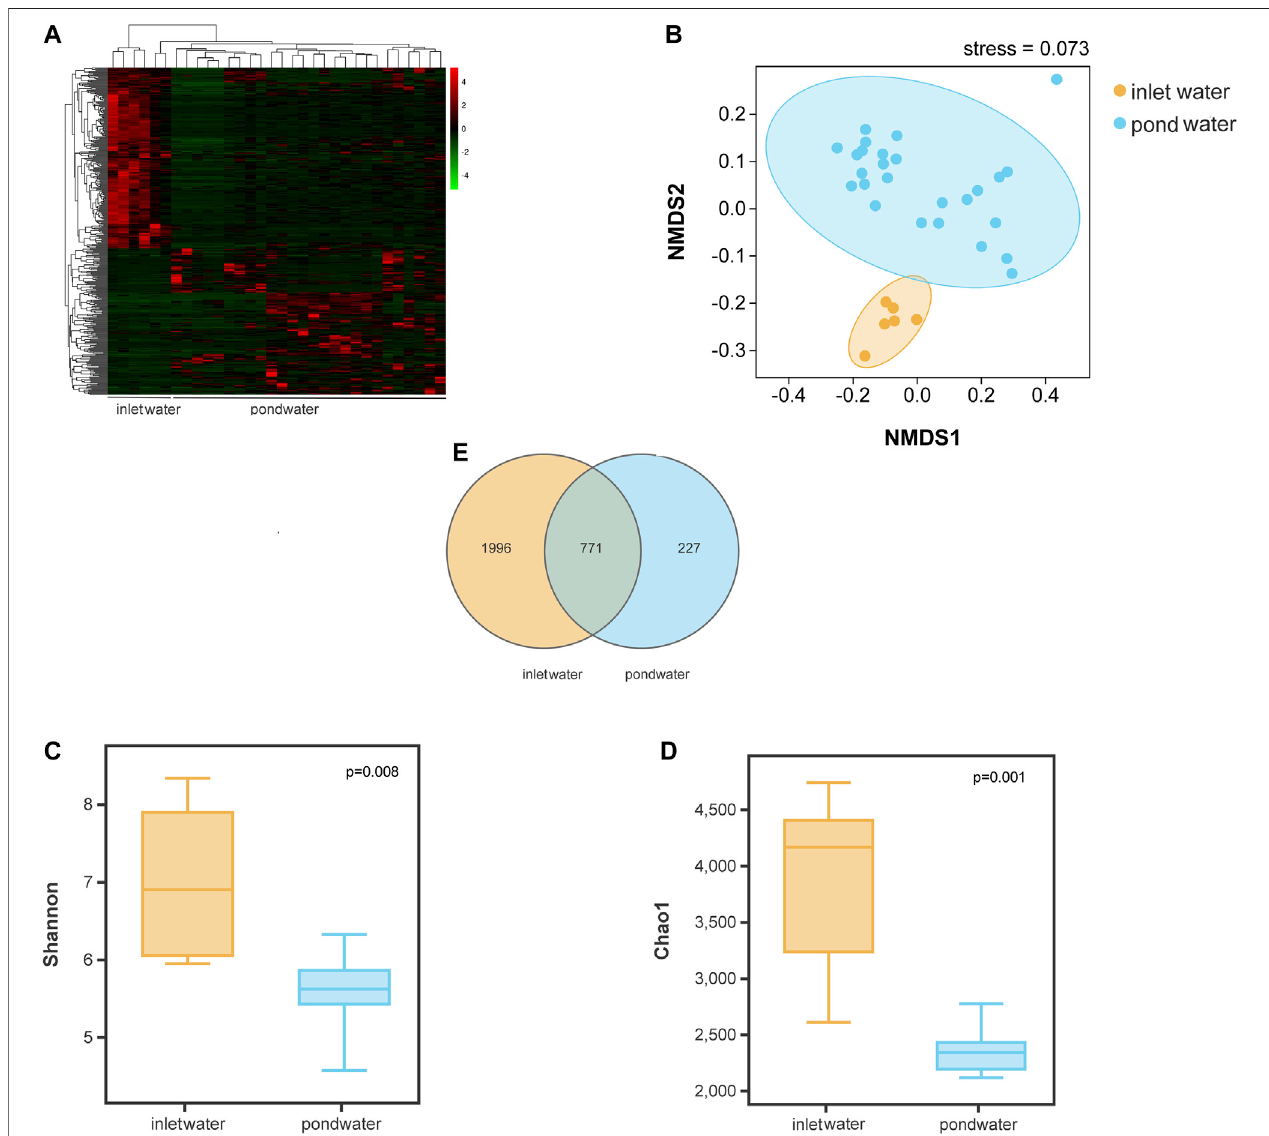
FIGURE2| Analysisofsigni fi cantdifferencesinOTUsbetweeninletwaterandpondwater (A) ;NMDSanalysis (B) ofbacterialcommunitiesbetweeninletwaterand pond water samples; Welch ’ s t -test analysis of Shannon ’ s diversity index (C) and Chao1 index (D) of bacterial communities; Venn diagram analysis of OTU numbers in inlet water and pond water (E)